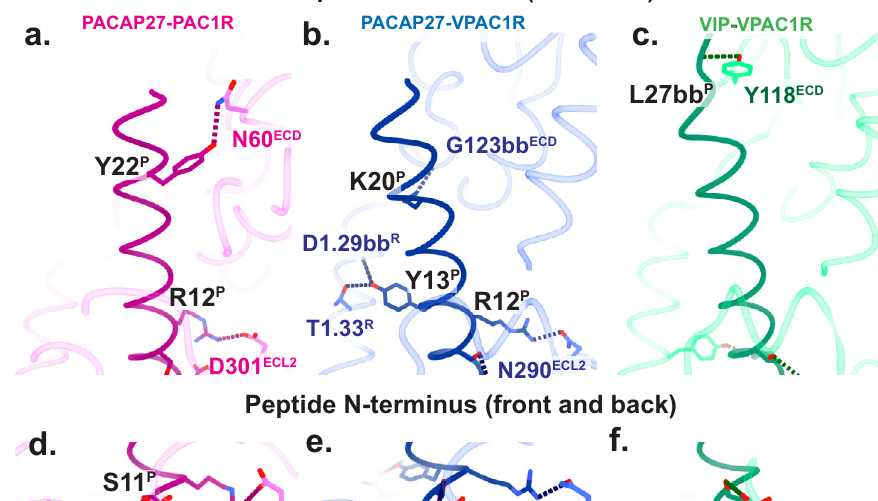
d – f Interactions of the peptide N-terminus and the receptor shown as front and back view. H-bonds between peptide and receptor are displayed as dotted lines. H-bonds involving backbones, and not sidechains, are labelled as ‘ bb ’ . Receptor residuesarenumberedaccordingtotheWoottenetal. 18